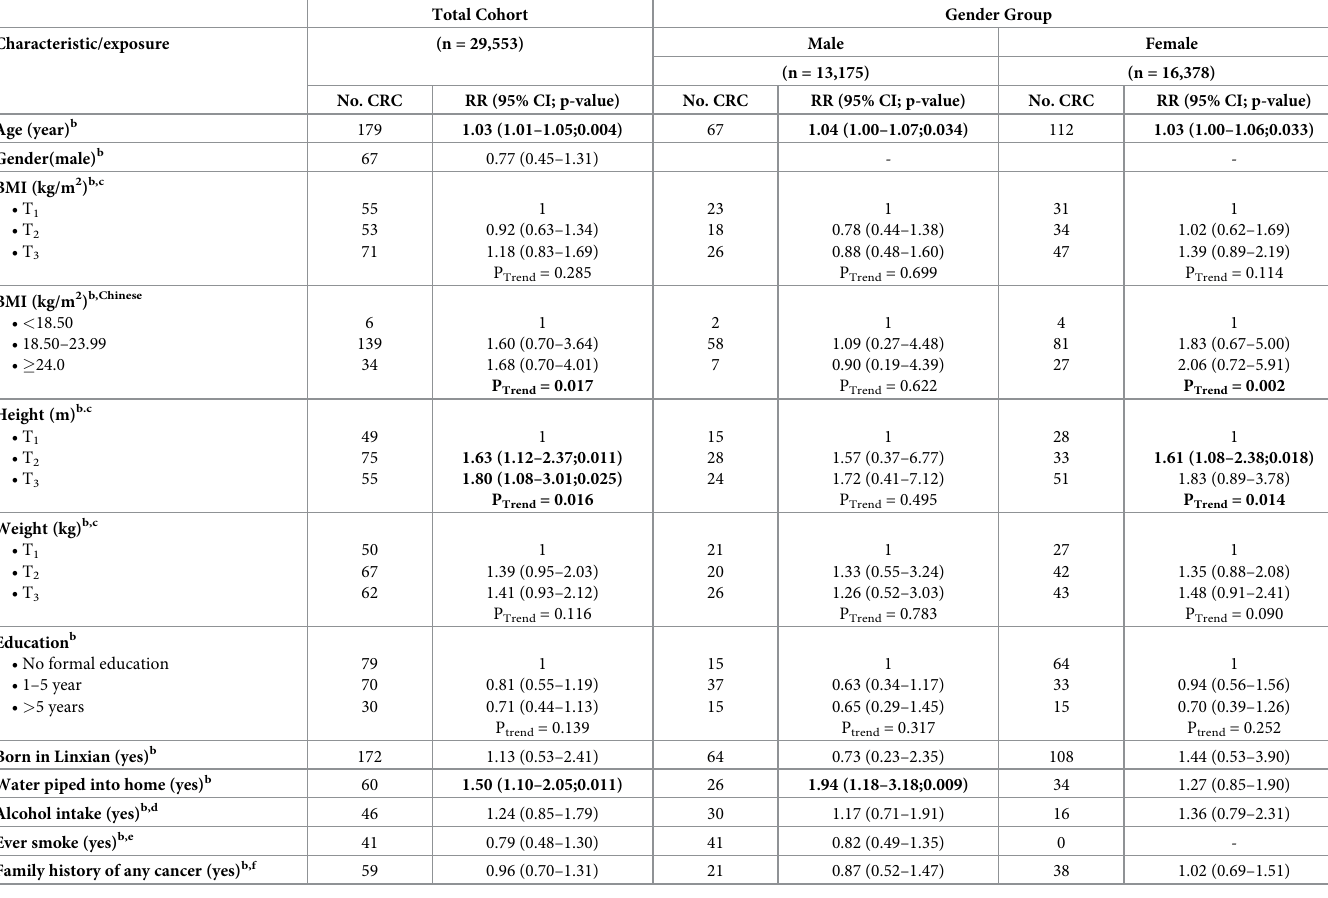
Table 1. Multivariate-adjusted RRs and 95% CIs for colorectal cancer for selected characteristics/exposures in the total cohort and by gender a